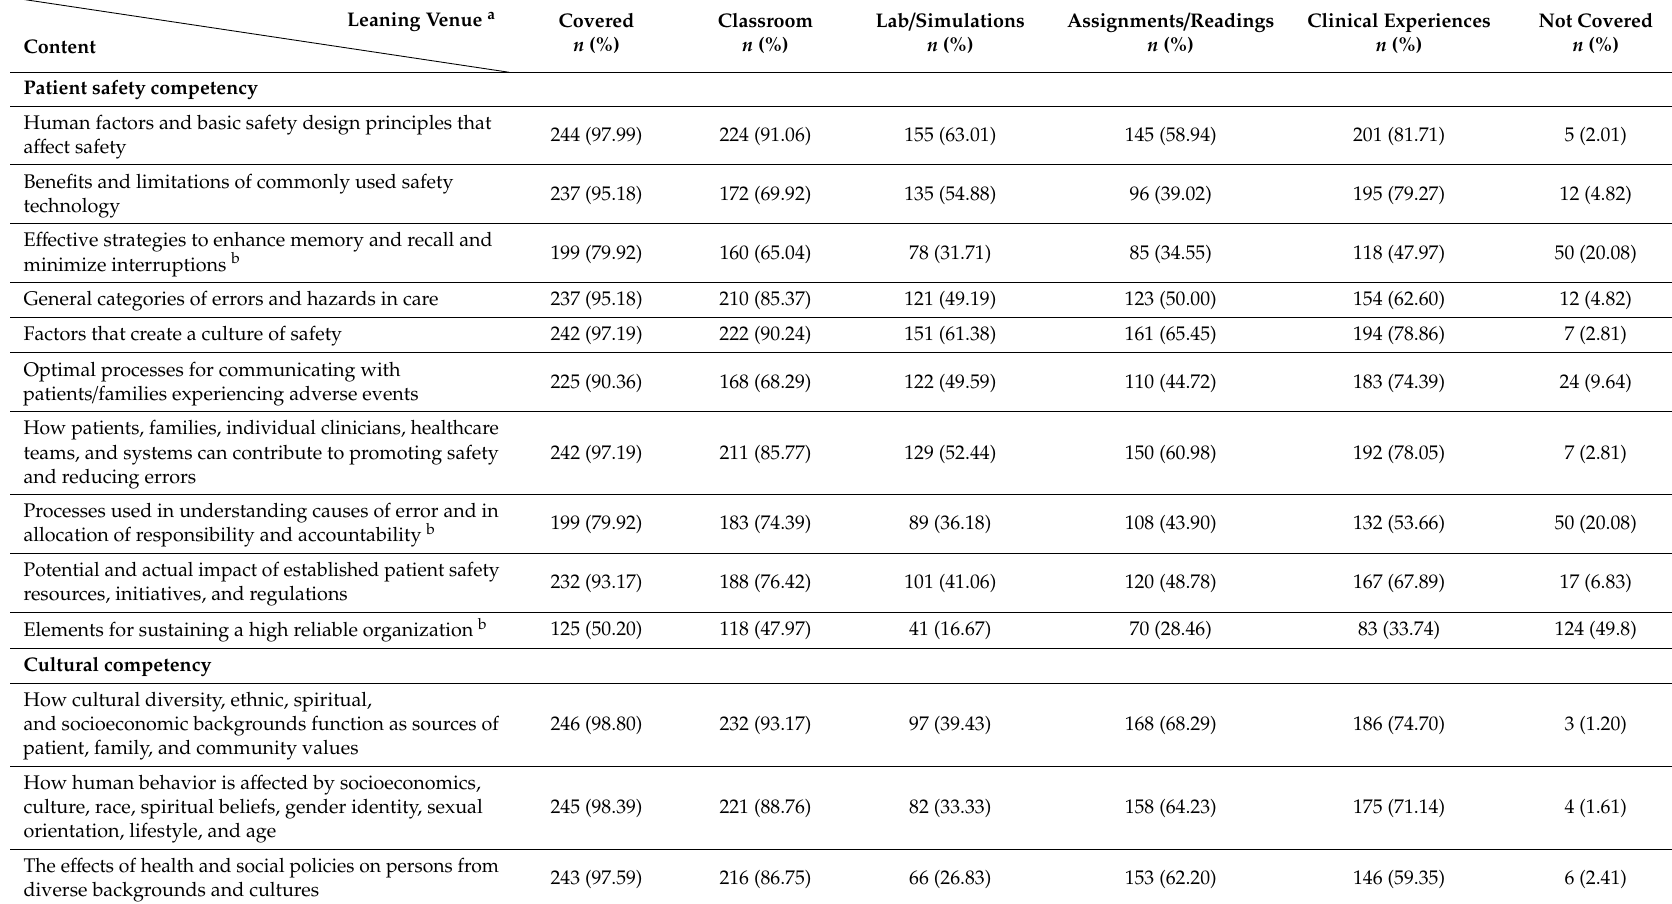
Table 2. Patient Safety and Cultural Competency Content Covered and Teaching Venues ( N =